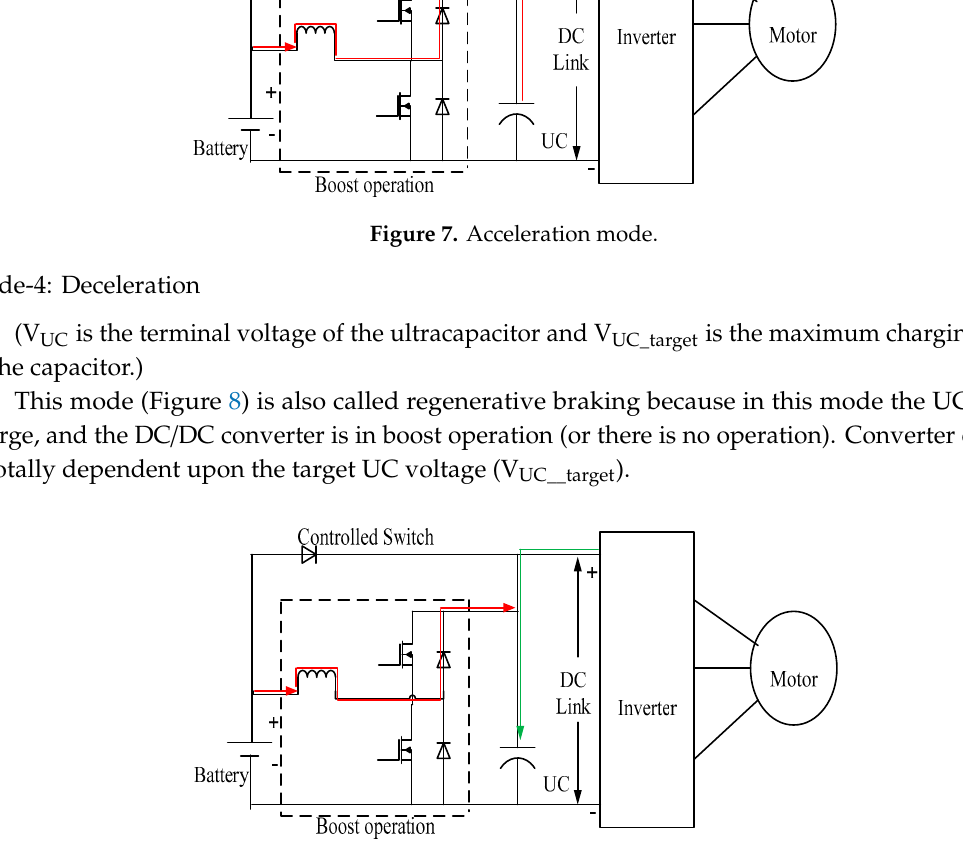
Figure 8. Regenerative braking when V UC < V UC__target .